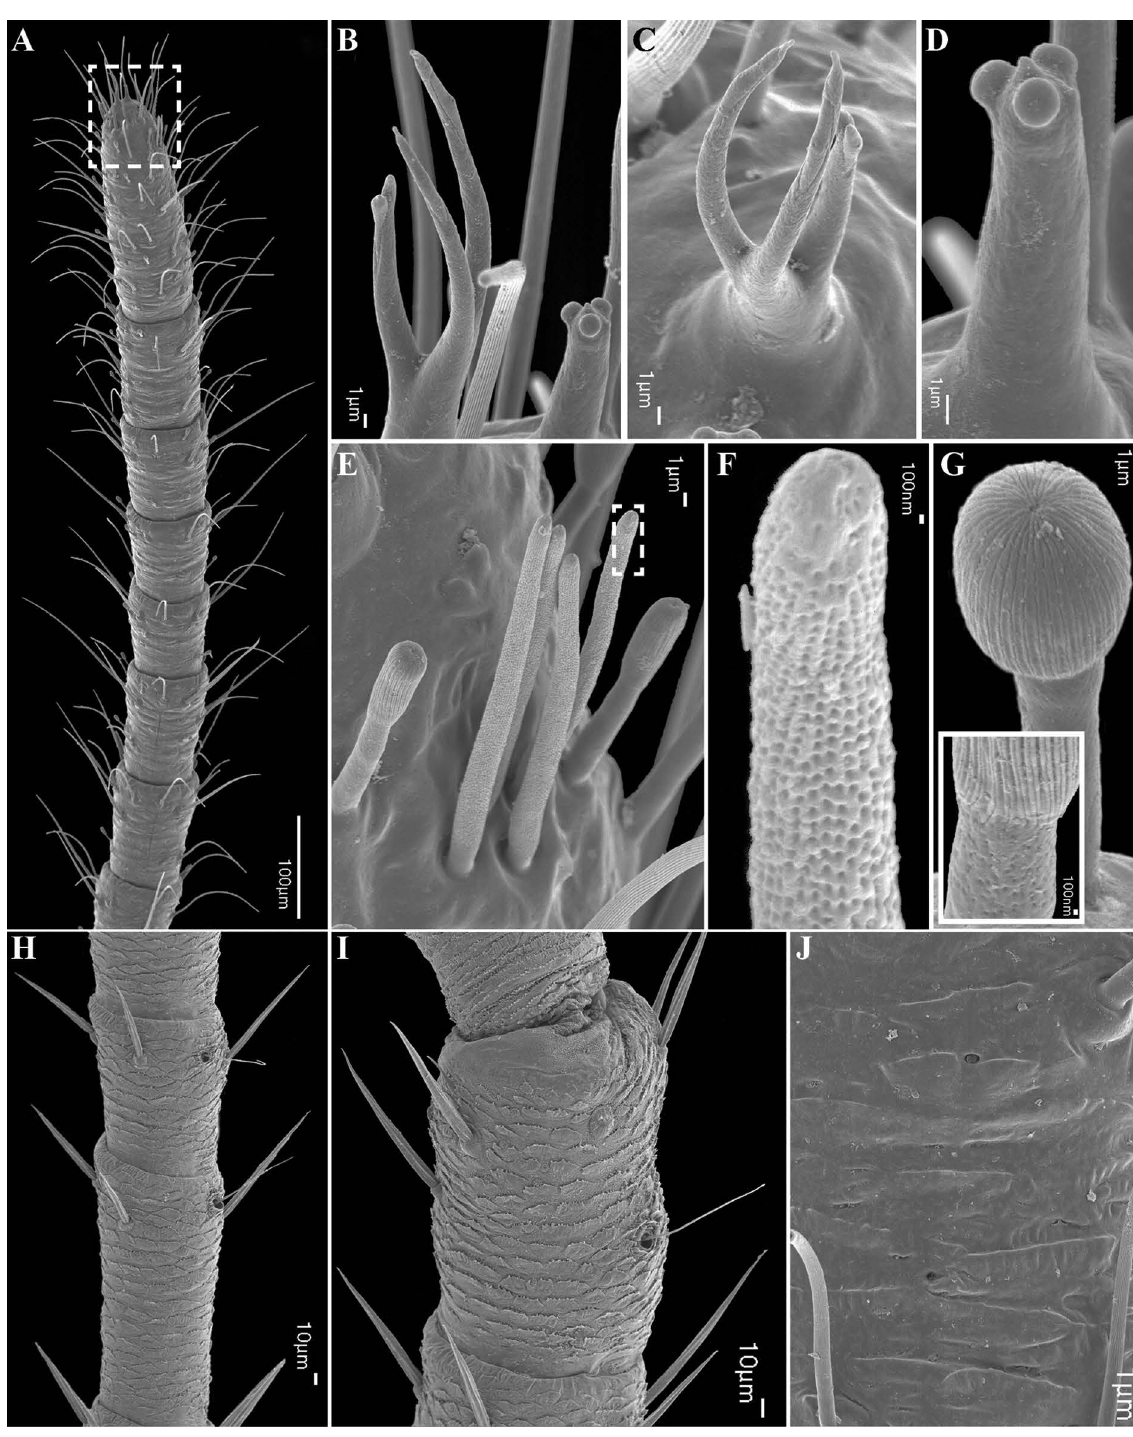
Fig. 23. Charinus dominicanus Armas & Perez, 2001 (AMNH), antenniform leg I, ♀. A . Distal tarsal articles. B . Apex of distal article showing modified claw and tarsal organ. C . Claw. D . Tarsal organ. E . Rod sensilla with olfactory setae. F . Apex of olfactory seta. G . Clavate setae. Inset: small punctures at setal base. H . Trichobothria on distal articles of tibia of leg I. I . Trichobothria on last article of tibia of leg I. J . Sensory gland opening on tarsal